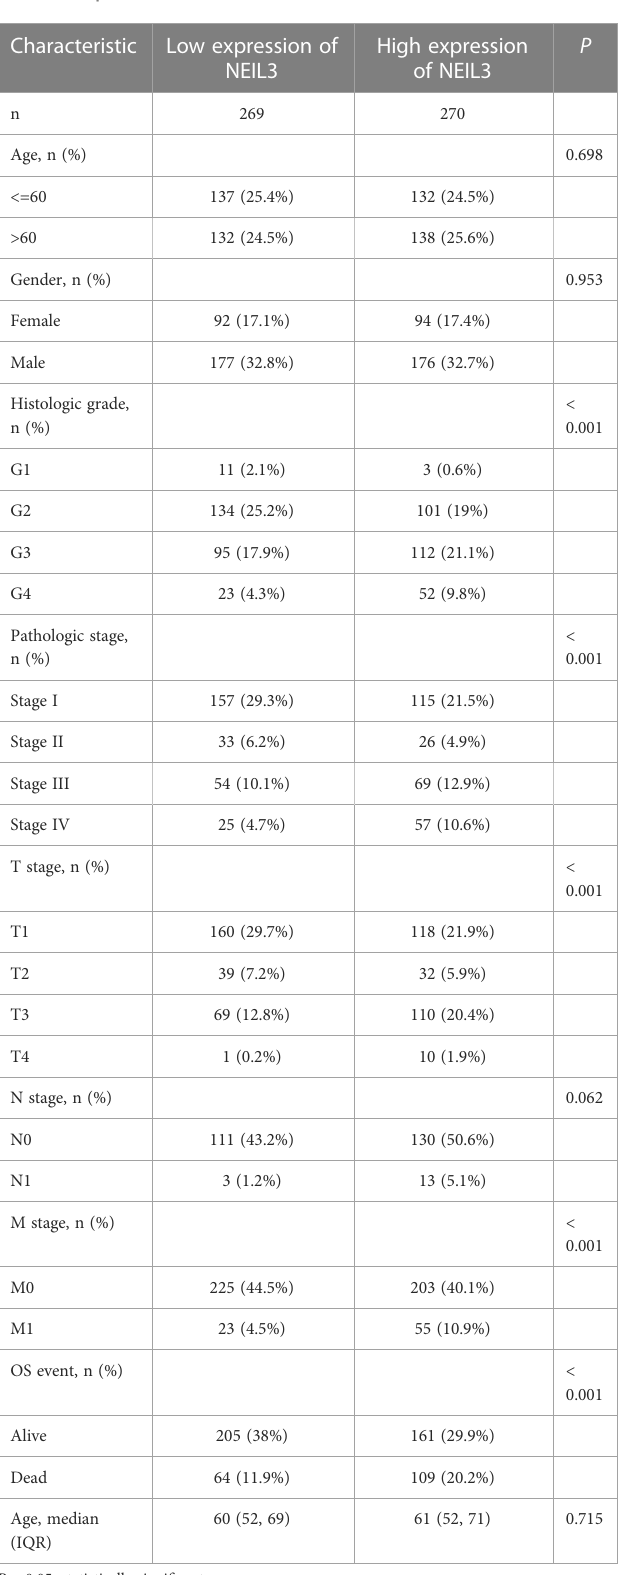
TABLE 1 Correlation between NEIL3 expression and clinicopathological variables in patients with